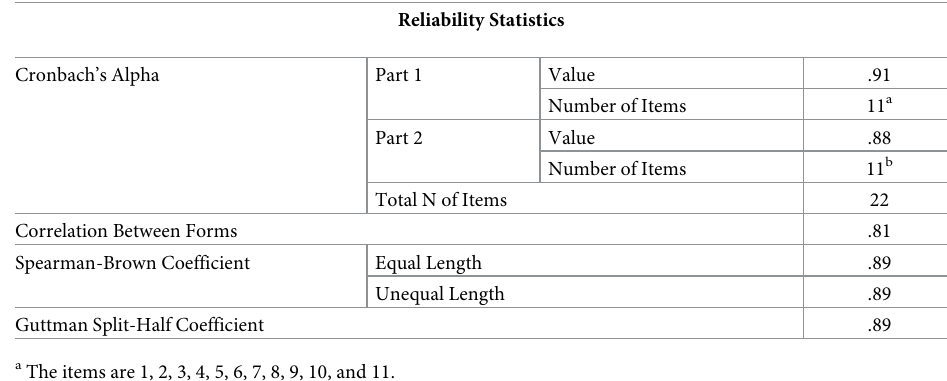
�� Correlation is significant at the 0.01 level (2-tailed) � Correlation is significant at the 0.05 level (2-tailed) EH, Empathy and Humanism; PR-D Professional Relationship and development.; R responsibility.